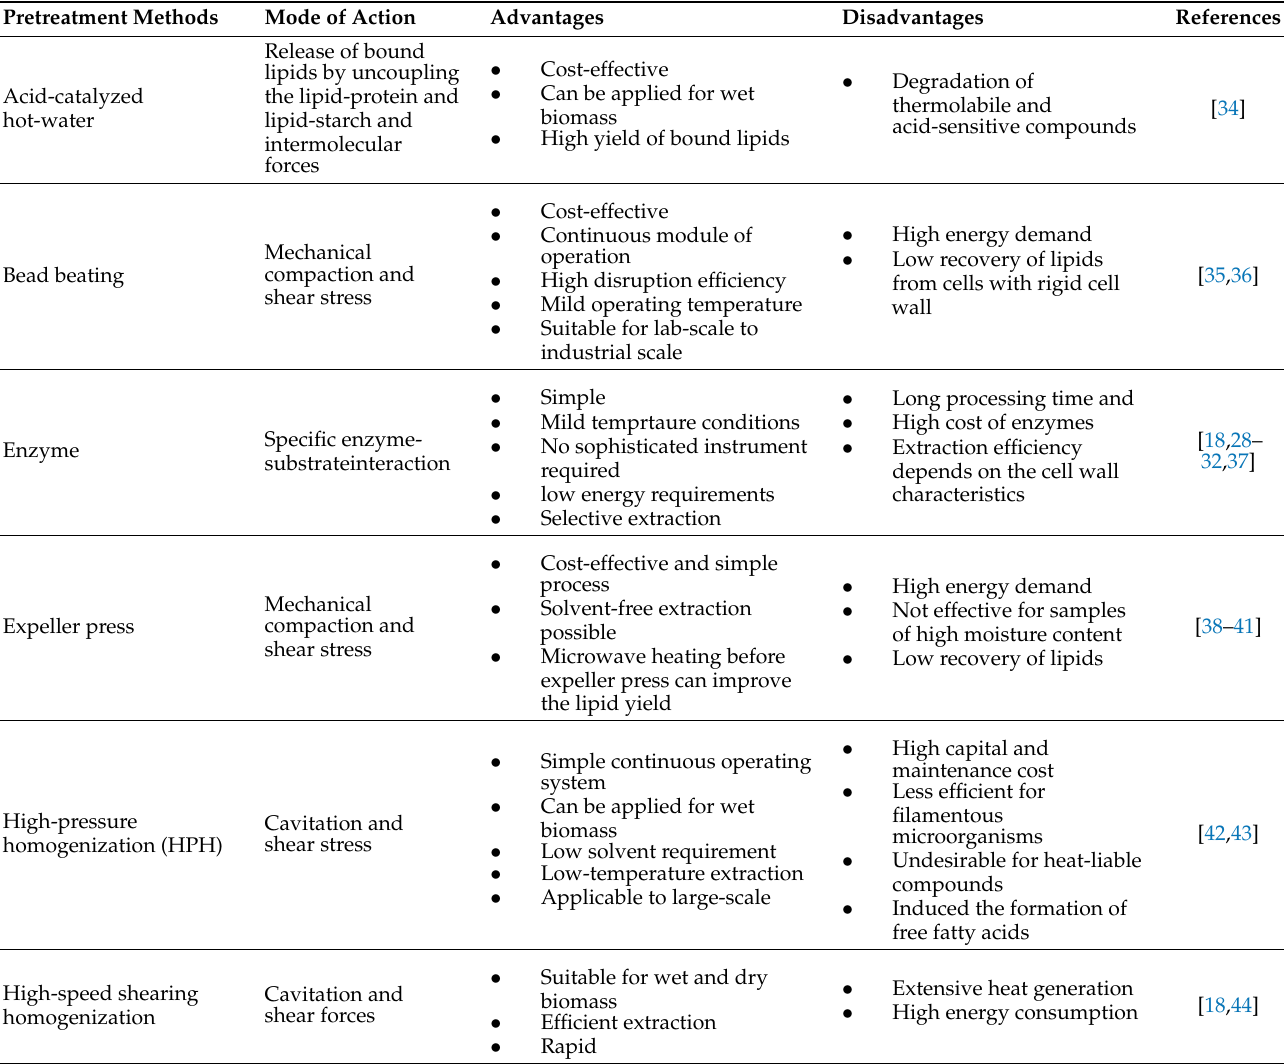
Table 1. The advantages and disadvantages of major pretreatment methods applied to the efficient extraction of lipids. Pretreatment